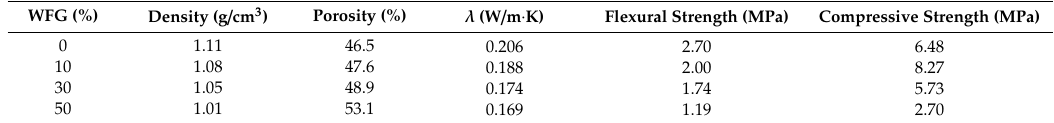
Table 3. Summary of the values of physical and mechanical properties of the produced composites.